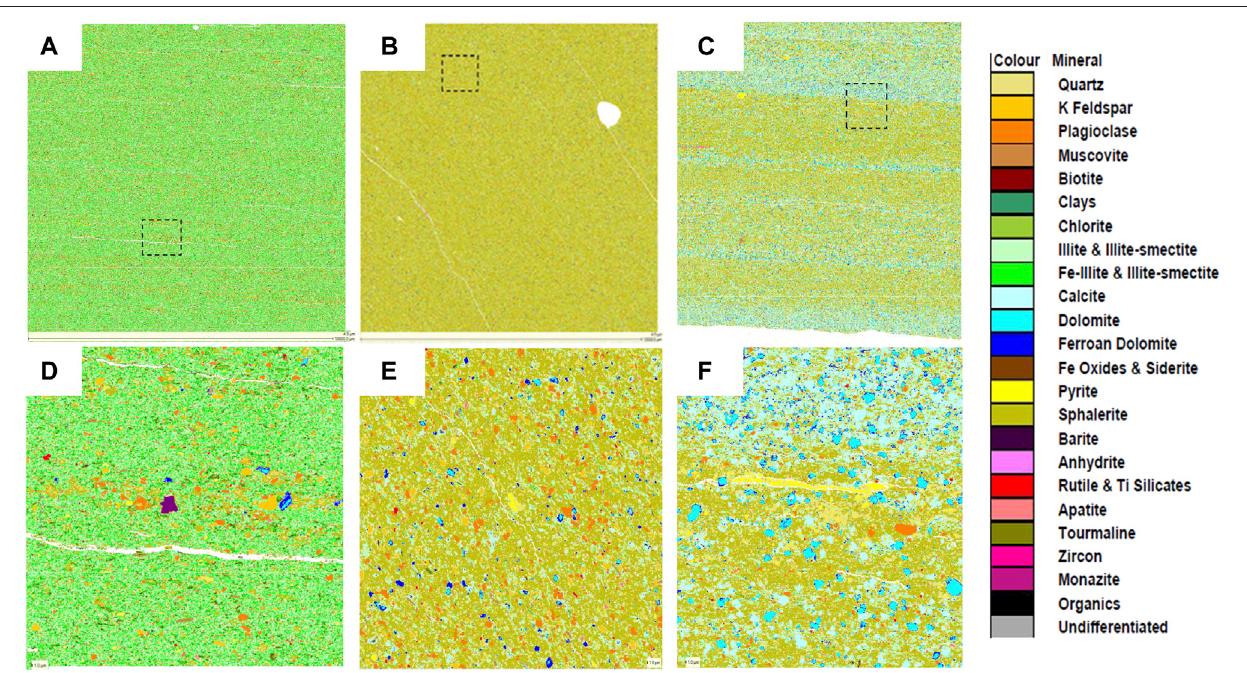
FIGURE 9 | QEMSCAN results for the three shale samples with an imaging resolution of 5 and 1 μ m. (A , D) Sample Sw-1, argillaceous shale, fi ne-to-medium silt sizegrainsofquartzandplagioclasewithinanillite-dominatedclaymatrix,witha fi nelaminationde fi nedbythepreferentialalignmentof fl akesofclays. (B , E) SampleJY9, siliceousshale,homogeneous,comprisingpredominantlymedium-to-coarsesiltgradequartz. (C , F) SampleWY23-6-6,mixedshale,comprisingthickbandsofmedium to coarse-grained quartz and fi ne-to medium-grained carbonate bands, with an illite clay matrix.